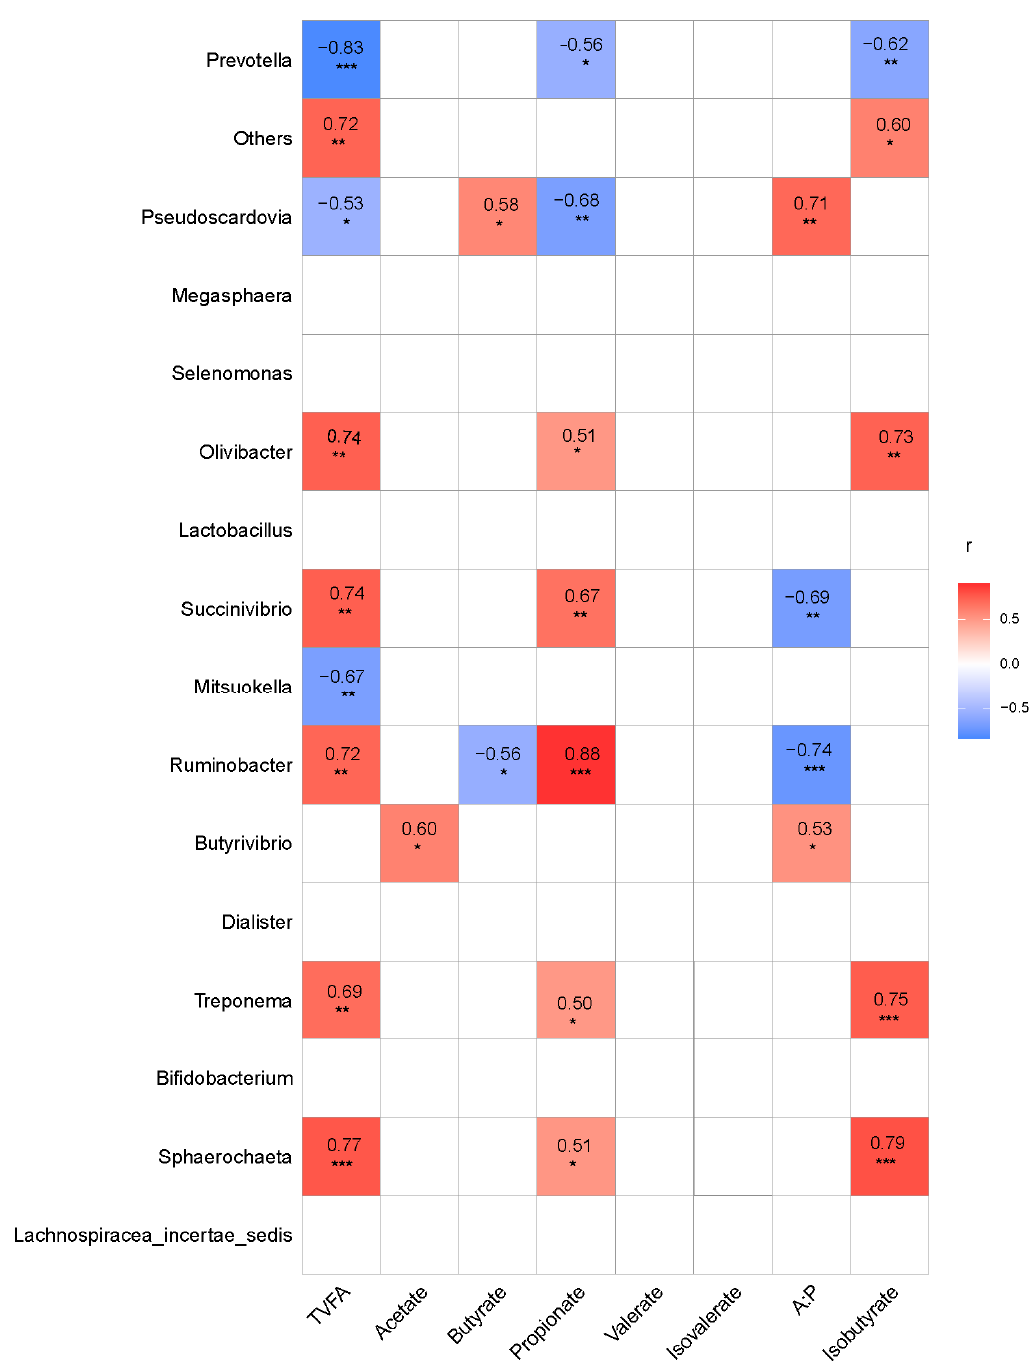
Figure 3. Correlation heat map. * p < 0.05, ** p < 0.01, *** p < 0.001.